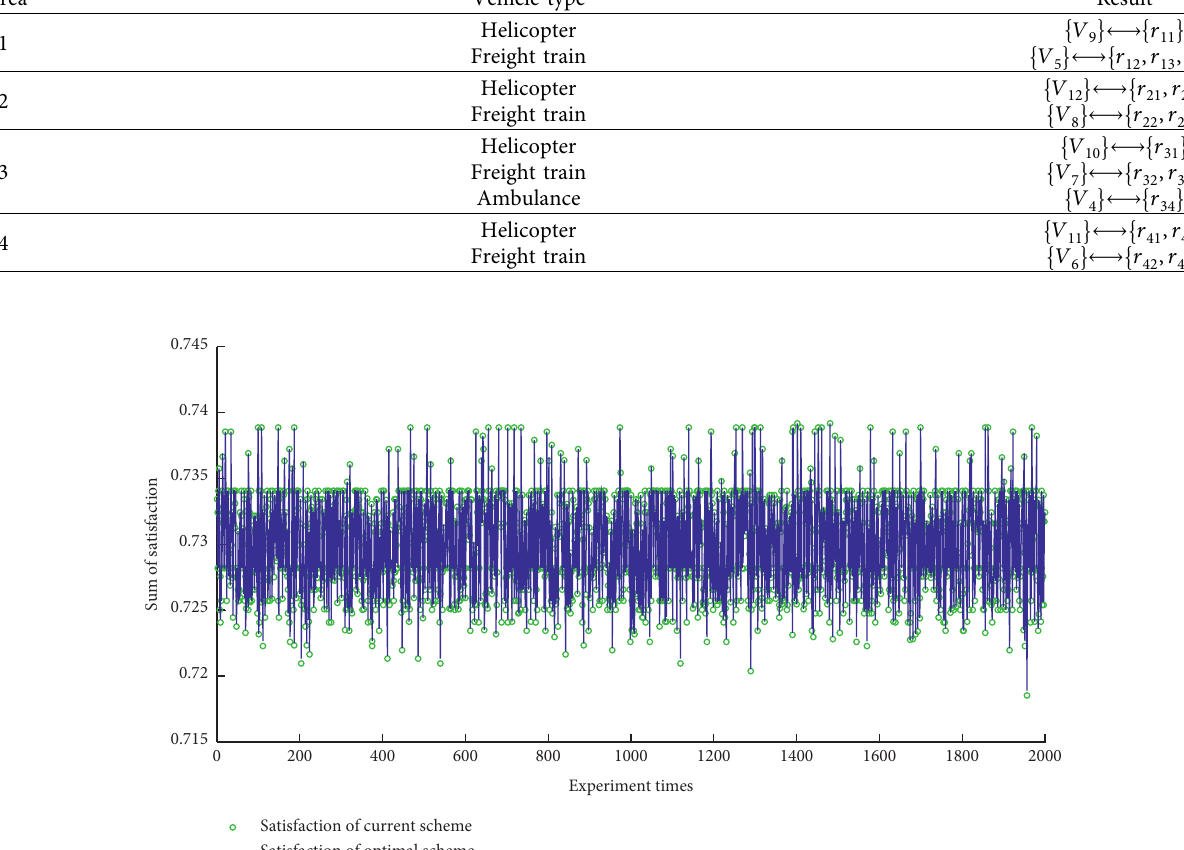
Figure 2: Comparison between the κ -current and the κ